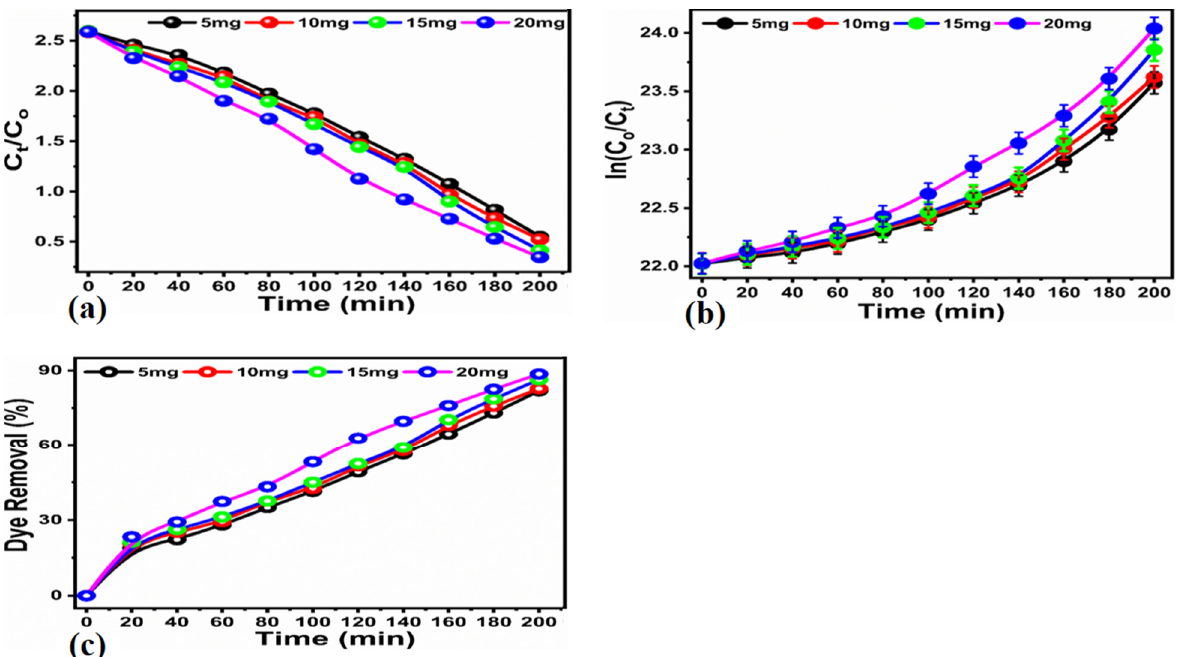
Figure 9. High concentration absorption spectra under UV irradiation for psyllium-added ZnO with various concentrations of 5 mg ( a ), 10 mg ( b ), 15 mg ( c ), and 20 mg ( d ).